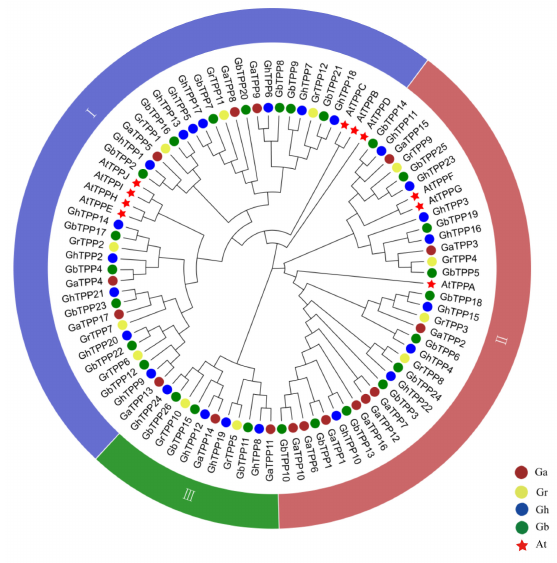
Figure 1. Phylogenetic analysis of TPP family genes in cotton and Arabidopsis . The brown, yellow, blue, and green circles represent G. arboreum , G. raimondii , G. hirsutum and G. barbadense , respectively, and the red stars represent Arabidopsis . Groups I–III are shown in blue, red, and green colour,